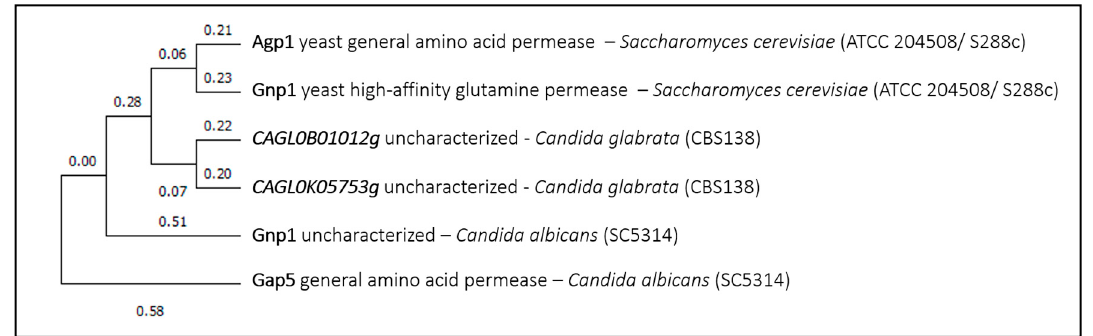
Figure 4. Agp1 phylogenetic analysis. The tree with the highest log likelihood is shown. This analysis involved six amino acid sequences. There were a total of 680 positions in the final dataset. Evolutionary analyses were conducted in MEGA X.